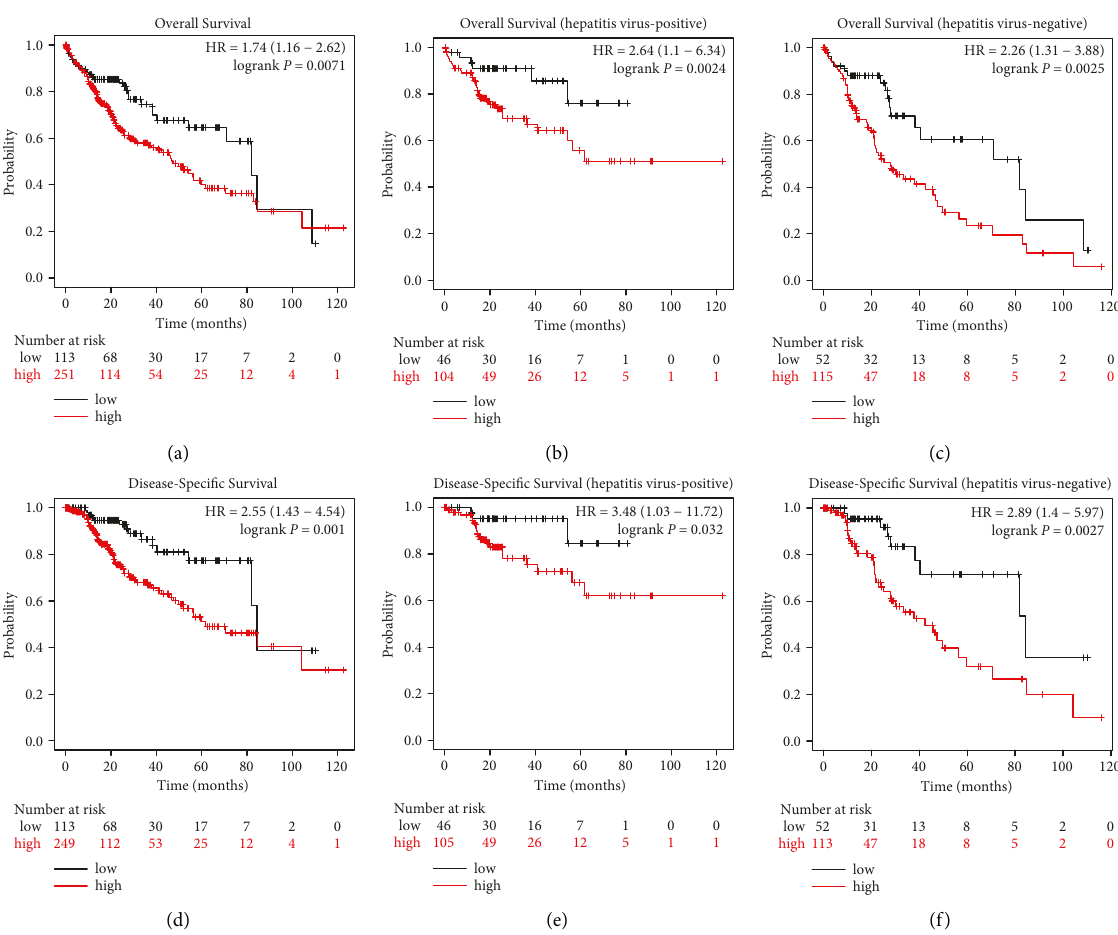
Figure 3: Kaplan–Meier survival curves of LIHC patients with highly expressed and lowly expressed HM13. (a) Survival curves of OS in LIHC patients in KM-plotter database. (b–c) Survival curves of OS in LIHC patients with or without hepatitis virus in KM-plotter database. (D) Survival curves of DSS in LIHC patients in KM-plotter database. (e–f) Survival curves of DSS in LIHC patients with or without hepatitis virus in KM-plotter